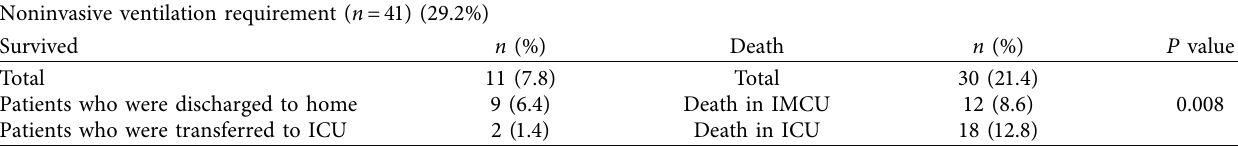
Table 2: Percentage of death and survival in patients who required NIVM.